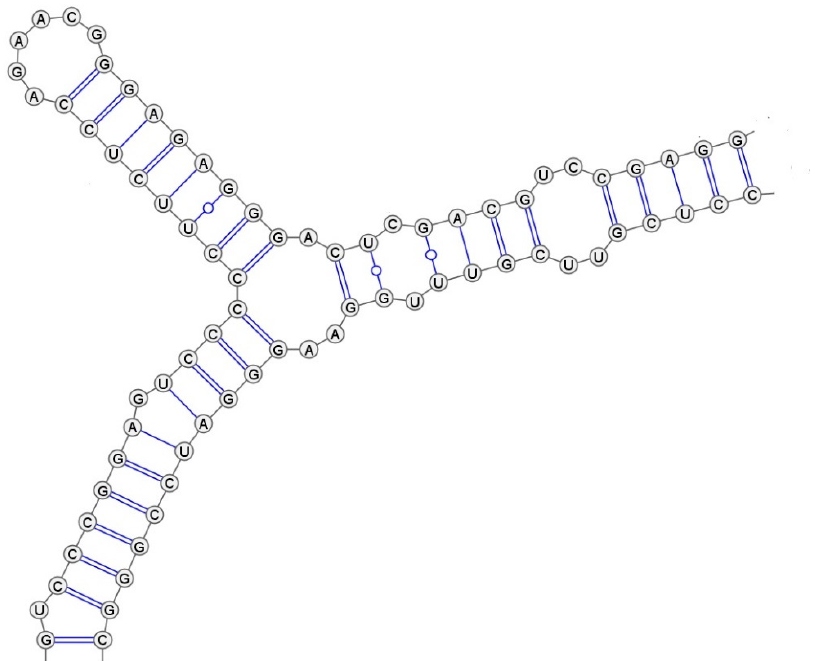
Figure 1. A zoom-in of Figure 3(A) in [4], where the folding prediction by energy minimization using either mfold/UNAFold [8] or Vienna’s RNAfold [9] of MG711735 from genotype 7 [5] is performed, with an SL1-like hairpin that contains the sub-sequence “GAAC” as in SL1 from genotype 3. The secondary structure is drawn using VARNA [10].